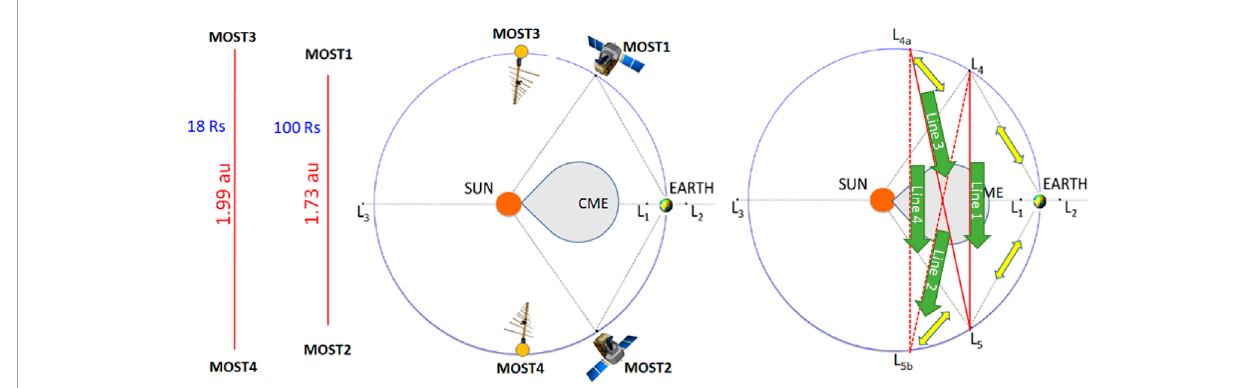
FIGURE 1 Overview of the MOST mission with the four constituent spacecraft at L4 (MOST1), L5 (MOST2), ahead of L4 (L4a, MOST3), and behind L5 (L5b, MOST4). MOST3 and 4 will carry only radio equipment for FETCH. MOST1 and 2 will have identical remote-sensing and in situ instrument suites. The approximate MOST1 → MOST2 and MOST3 → MOST4 distances are shown at the left, indicating the long signal paths for spacecraft radio signals. (Blue text shows the offset distance to the point-of-closest-approach between the LOS and the Sun). The red lines in the right indicate FETCH signal paths; the green arrows label these paths line 1–4 and give the forward directions. This enables a rudimentary radio tomographic image using FR (Fung et al., 2022). The yellow double arrows indicate communication links to Earth. Note that MOST3 and 4 slowly shift position between L4 and 5 and the locations shown throughout the MOST mission [adapted from Gopalswamy et al.